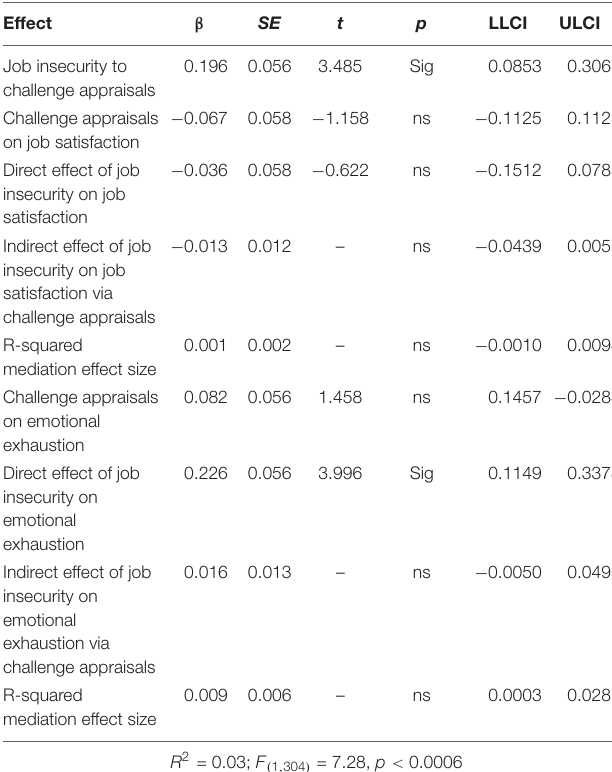
TABLE 3 | Regression results (standardized regression coefficients) predicting the outcomes ( N = 306).